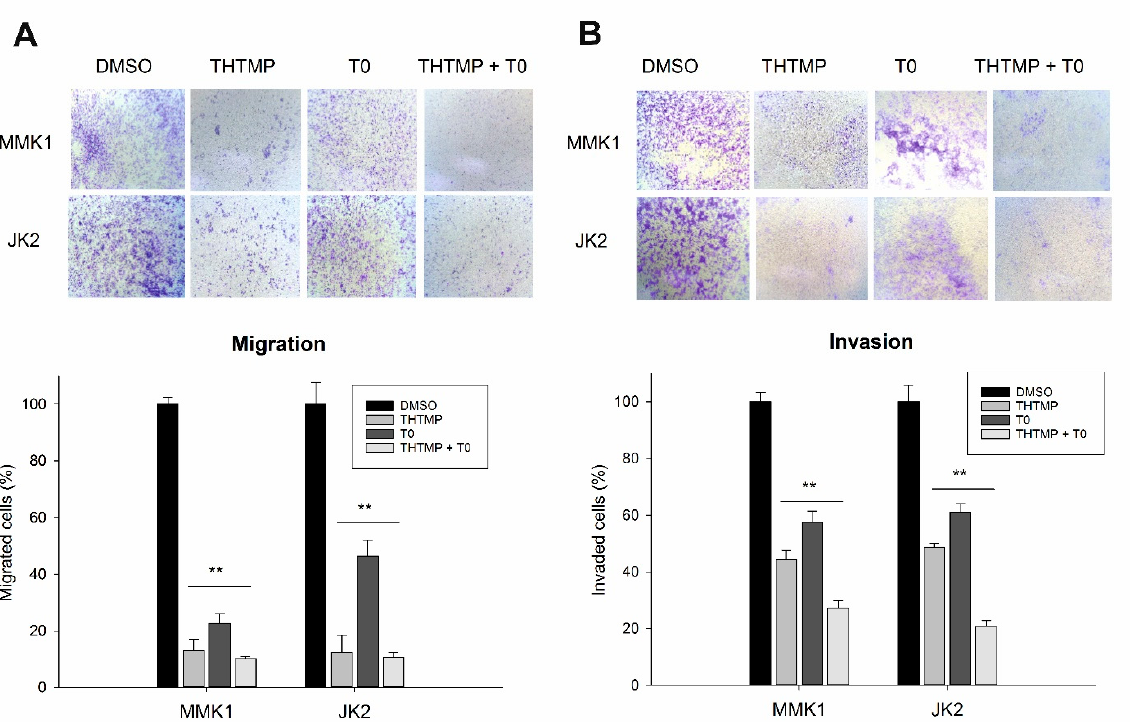
Figure 3. Analysis of cell migration and invasion assay. Effect of DMSO (control), THTMP, T0 and combination of THTMP + T0 on cell migration ( A ), invasion ( B ) on MMK1 and JK2 using transwell method. Microscopic images are the representation of the % of migration and invaded cells captured in 40 × magnification. The data were shown as mean ± SD, n = 3, ** p < 0.01.